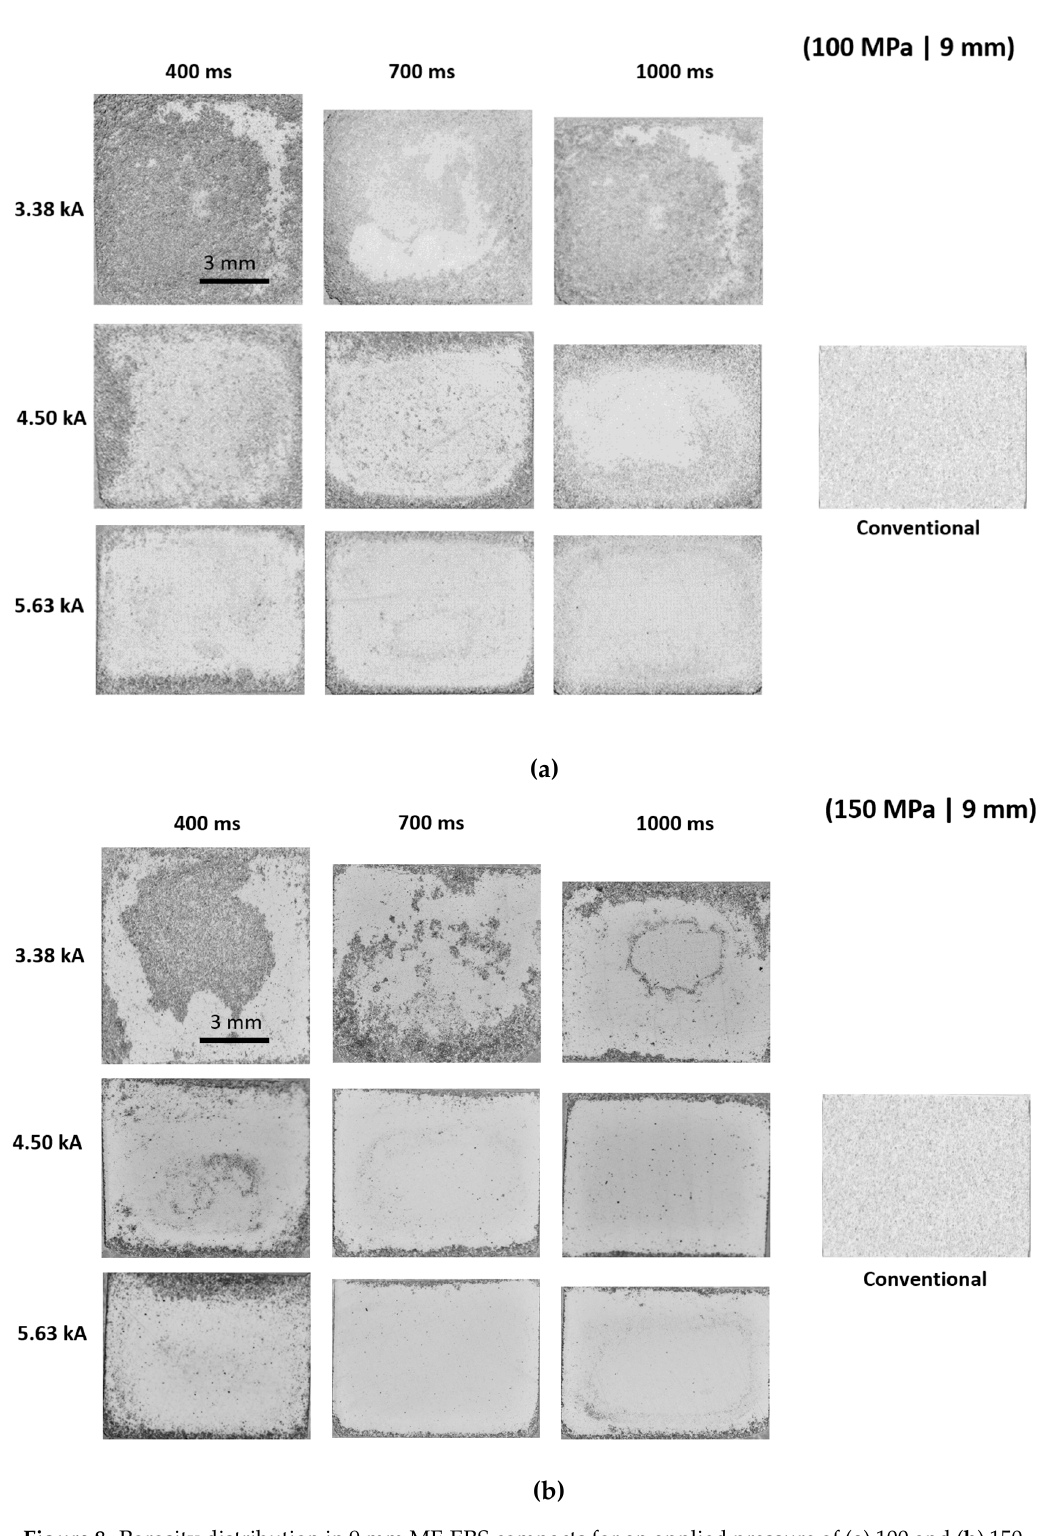
Figure 8. Porosity distribution in 9 mm MF-ERS compacts for an applied pressure of ( a ) 100 and ( b ) 150 MPa. The macrograph of the compact obtained by the conventional PM route is added for comparison. In all the images, clearer areas (more reflecting zones) indicate a lower porosity. Current flows in all cases from the top to the bottom of the images.